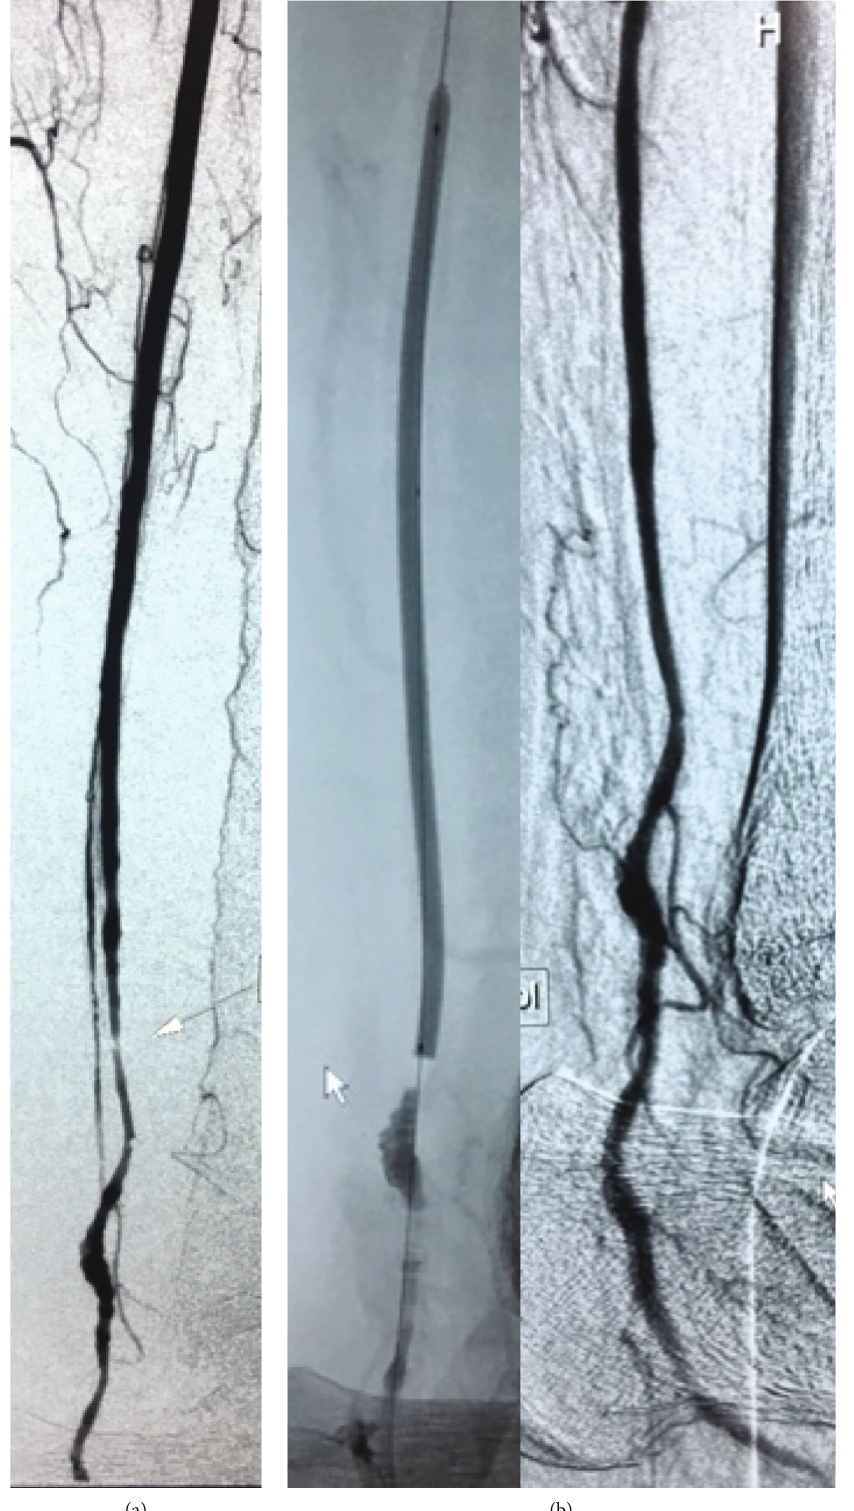
Figure 2: Completion angiography after open thrombectomy: residual stenosis of the posterior tibial artery treated with balloon